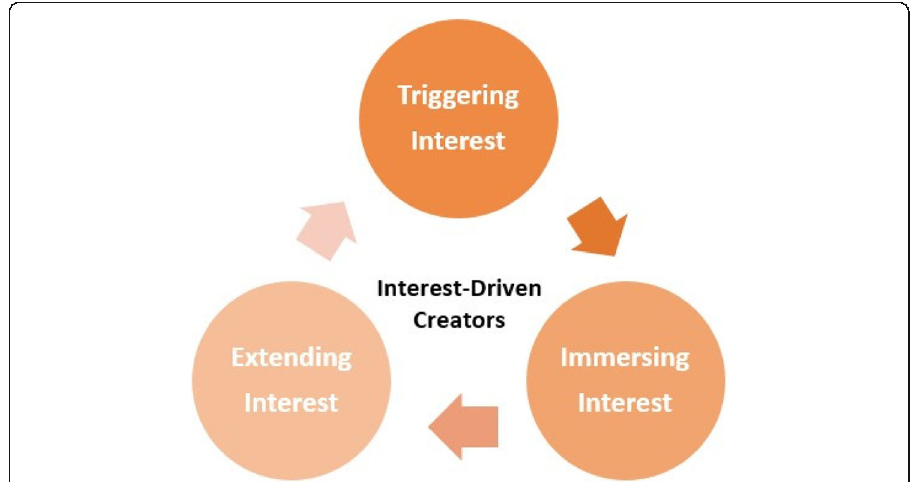
Fig. 1 Conceptual framework of interest